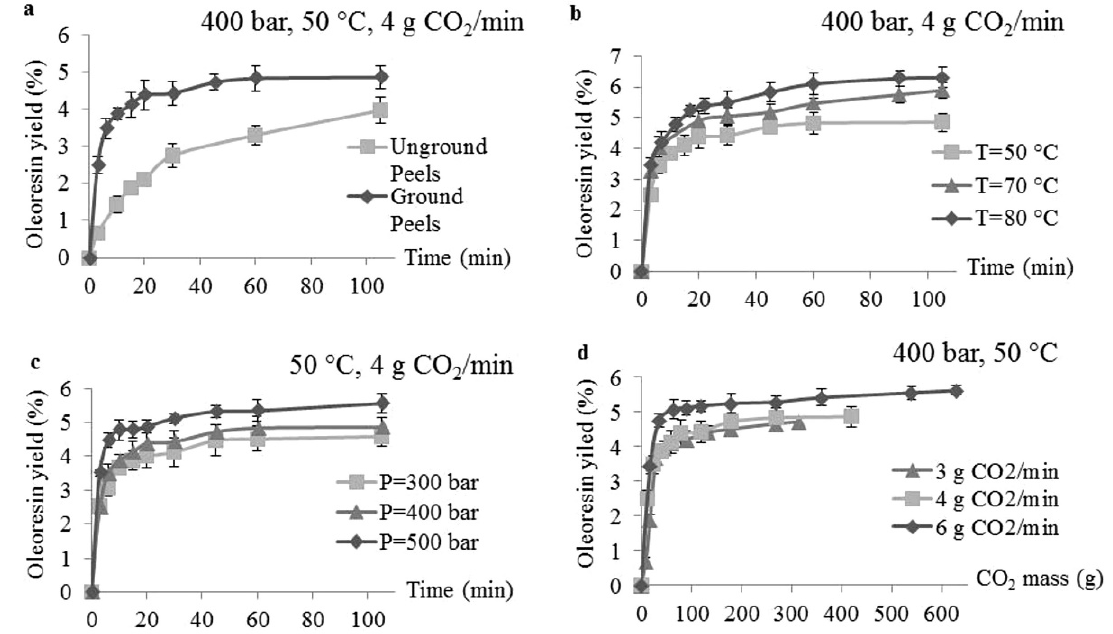
Figure 4. SFE curves (yield vs. time) of tomato peels (10 g) with SC-CO 2 to illustrate the effect of ( a ) particle size, ( b ) temperature, ( c ) pressure, and ( d ) flow rate. Reproduced from [79].